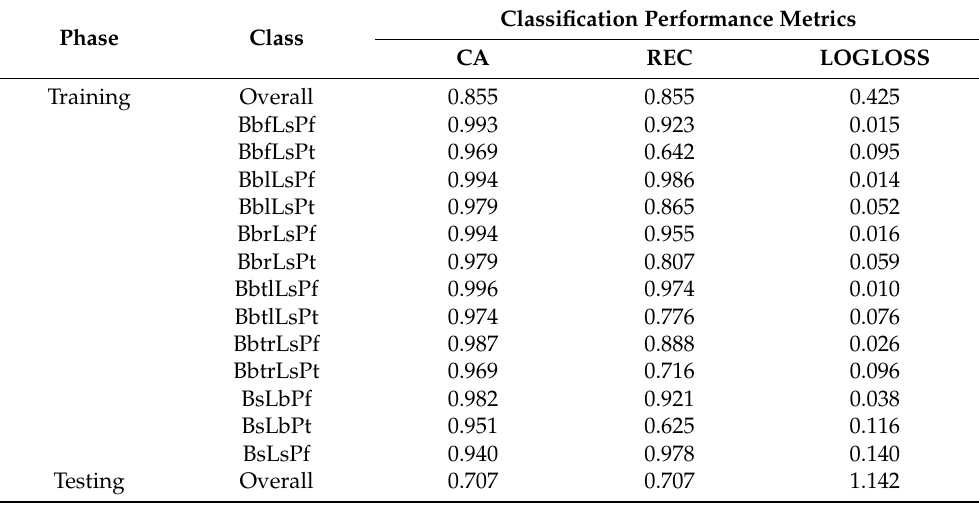
Table 3. Classification performance in the training and testing phases to differentiate the postures of the back by the MLPBNN machine learning algorithm with the regularization term set at α =